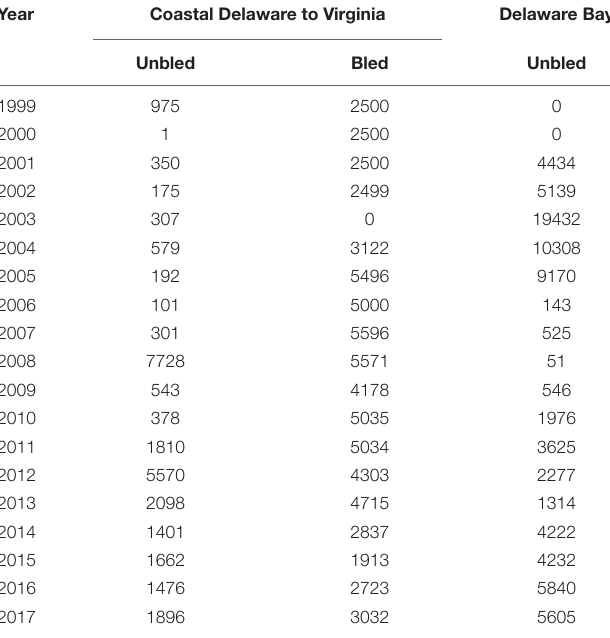
TABLE 1 | Tag releases within coastal Delaware to Virginia and Delaware Bay from 1999 to